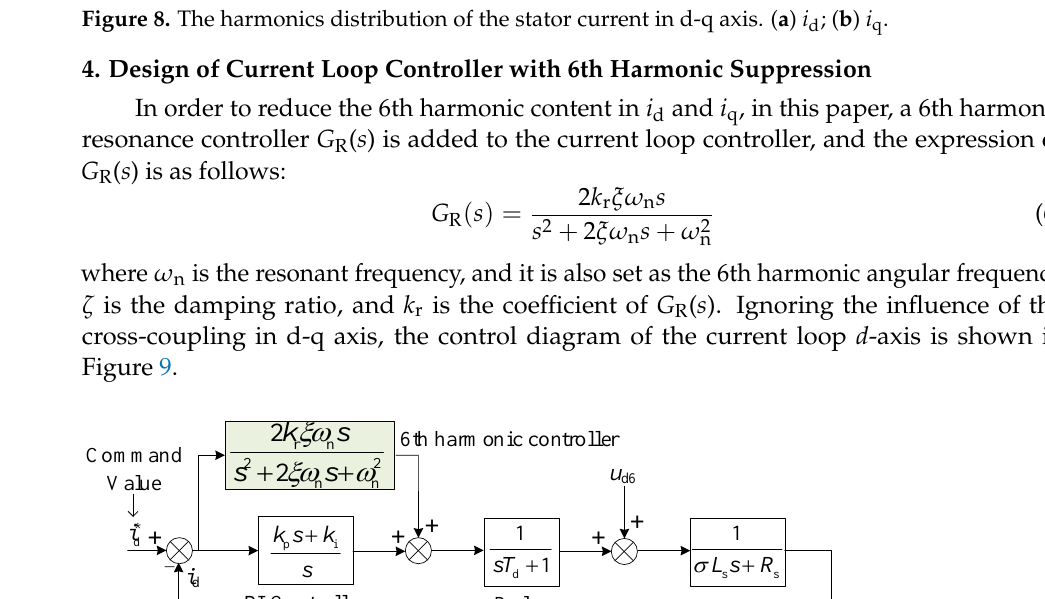
Figure 8. The harmonics distribution of the stator current in d-q axis. ( a ) i d ; ( b ) i q .